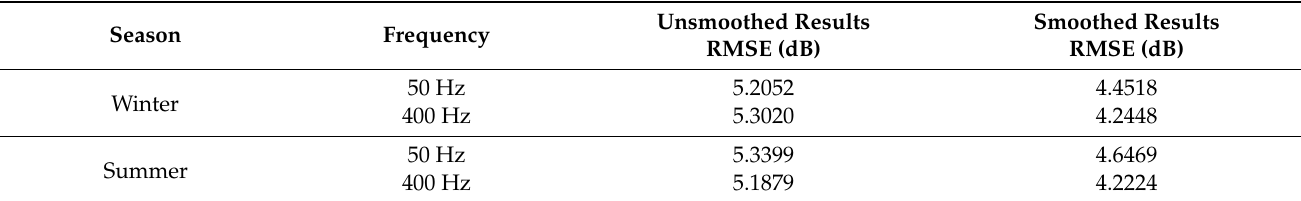
Table 3. Comparison between the TL calculated through the model and the actual situation at different seasons and different frequencies (the sound source depths were 100 m, 300 m, and 500 m, respectively).